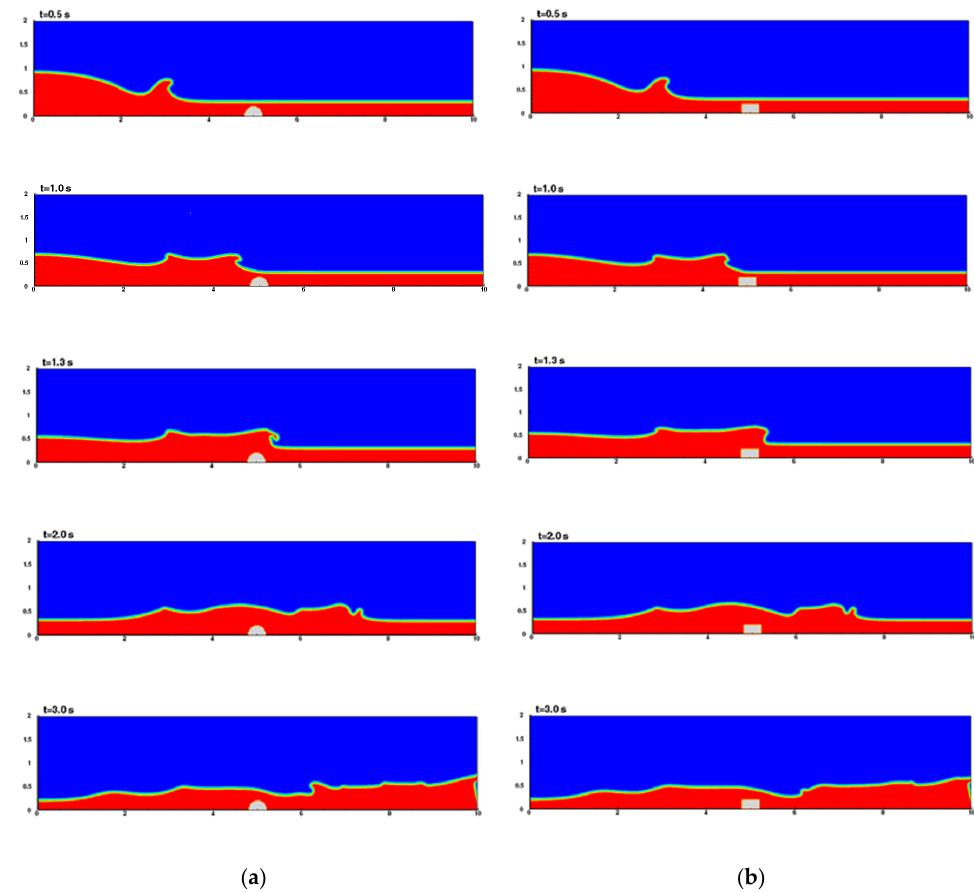
Figure 15. Density distributions of a dam ‐ break wave over submerged structures at different times: ( a ) semicircular cylinder and ( b ) rectangular cylinder.